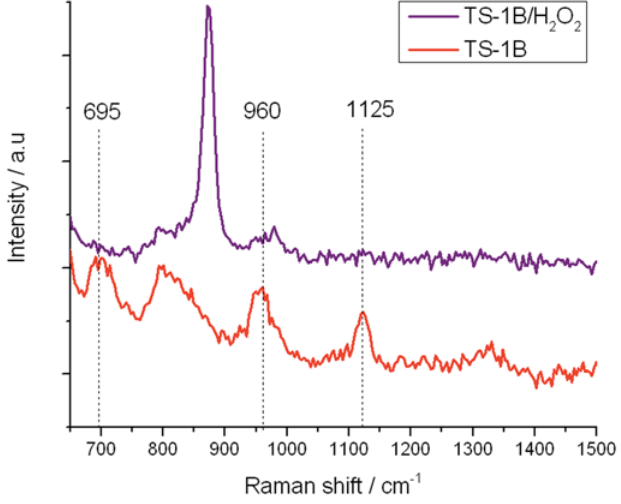
Figure 10. In situ UV-Raman (325 nm) spectra of (red) TS-1B and (purple) TS-1B treated with H 2 O 2